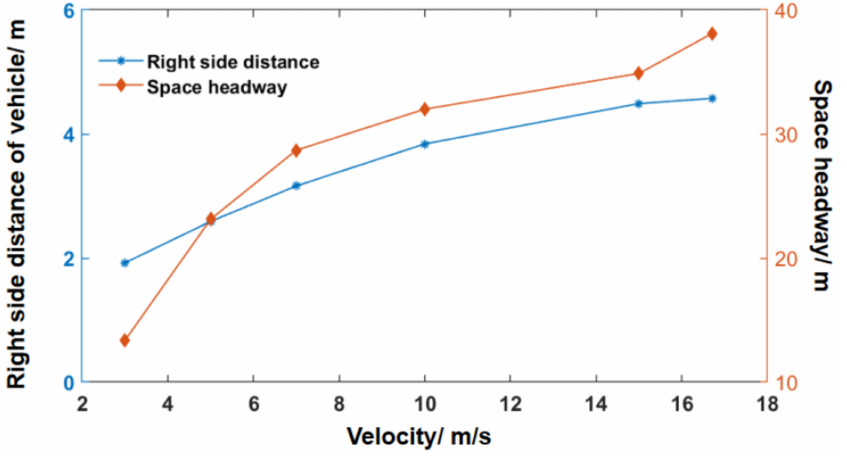
Figure 2. Relationship of vehicle velocity to forward and lateral